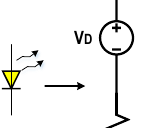
Figure 2. Flyback model in DCM for the LFAA. Figure 3. LED model.